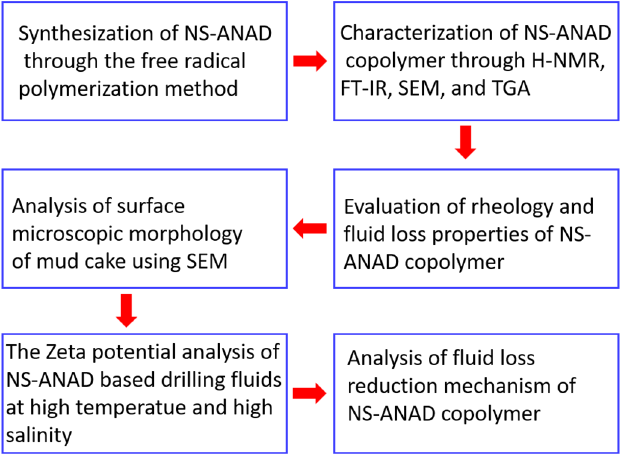
Figure 10. The workflow diagram of this research.